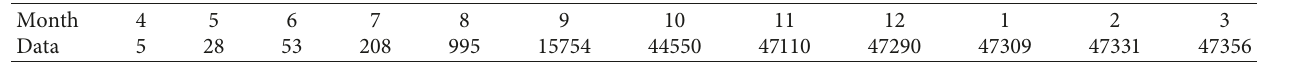
Table 1: Monthly cumulative confirmed data on dengue outbreaks from April 2014 to March 2015.